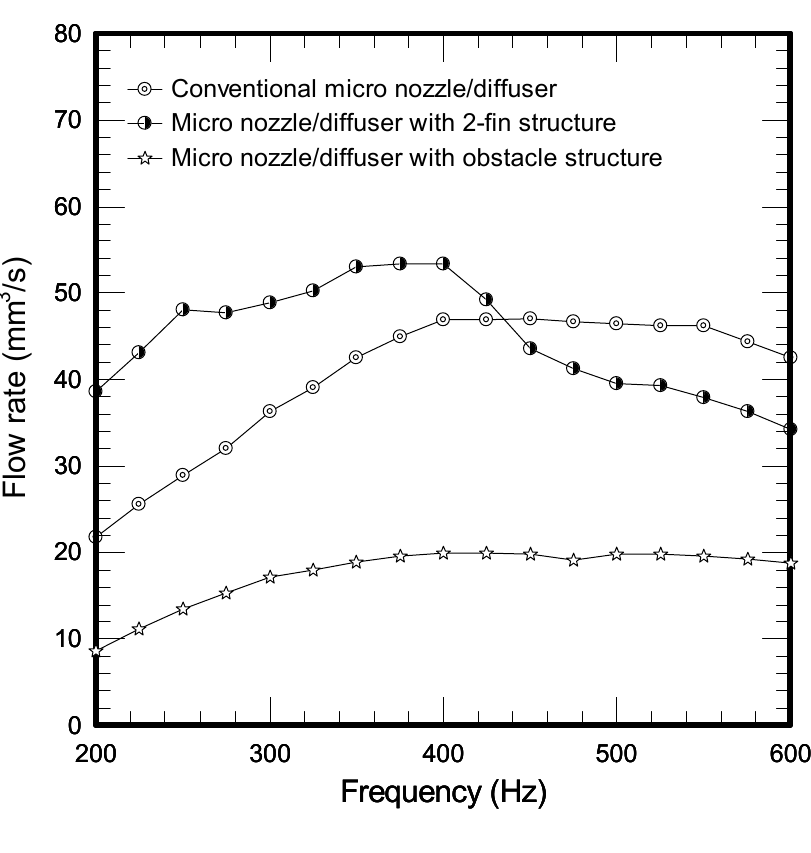
Figure 1. Frequency vs . flow rate for micropumps.